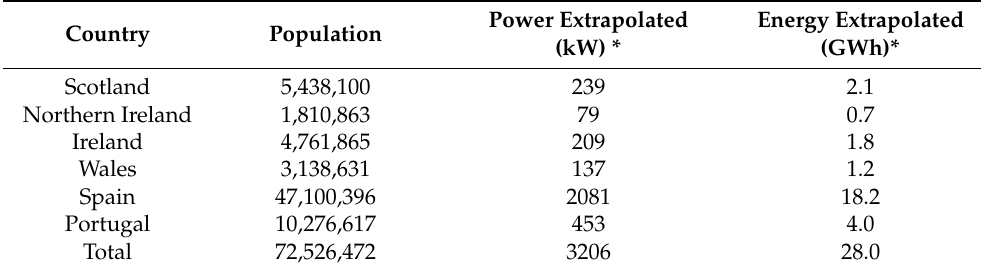
y represents the estimated power potential for wastewater treatment plant outlets (kW), and x represents the size of the population served by each plant. Table 4. Potential power for MHP estimated by country for the wastewater sector and extrapolated energy potential. Country